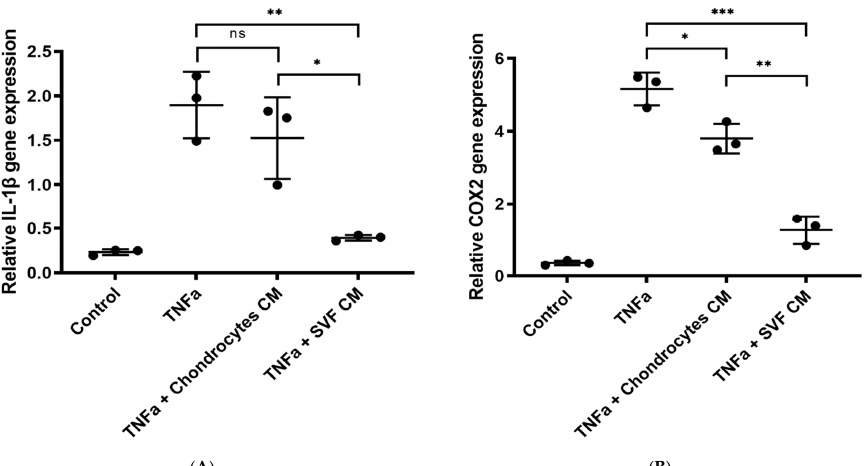
Figure 6. ( A ) Relative gene expression of interleukin (IL)- β ( A ) and cyclooxygenase 2 (COX2 (prostaglandin-endoperoxide synthase 2 (PTGS2)), ( B ) by tumor necrosis factor alpha (TNF α )-stimulated chondrocytes and subsequently treated with conditioned medium (CM) of chondrocytes or tissue-like stromal vascular fraction (tSVF) for 24h. Results are expressed as mean ± SD and analysed with an unpaired t-test. ns = not significant. * p ≤ 0.05. ** p ≤ 0.01. *** p ≤ 0.001. Control = chondrocytes without TNF α treatment.